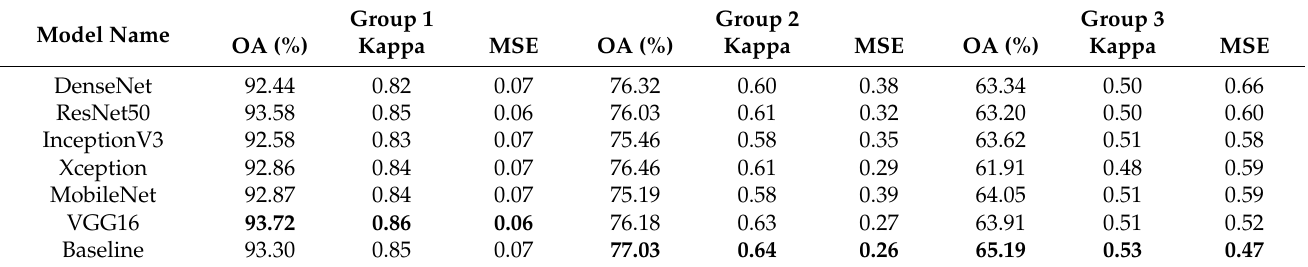
Table 7. The quantitative comparison of different baseline models for classification of building damage in the Yushu dataset.